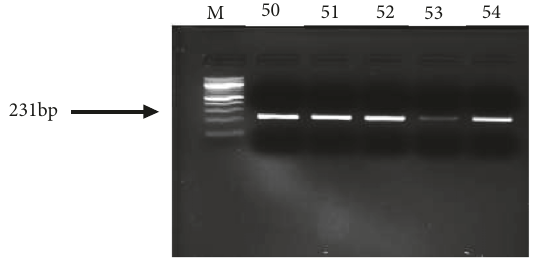
Figure 2: Agarose gel electrophoregram of ELAC2 gene amplified by touchdown PCR from participants’ genomic DNA extracts. Lane M = 100bp molecular weight marker and lane 50-54 = DNA amplicons of participants. Numbers represent participants’